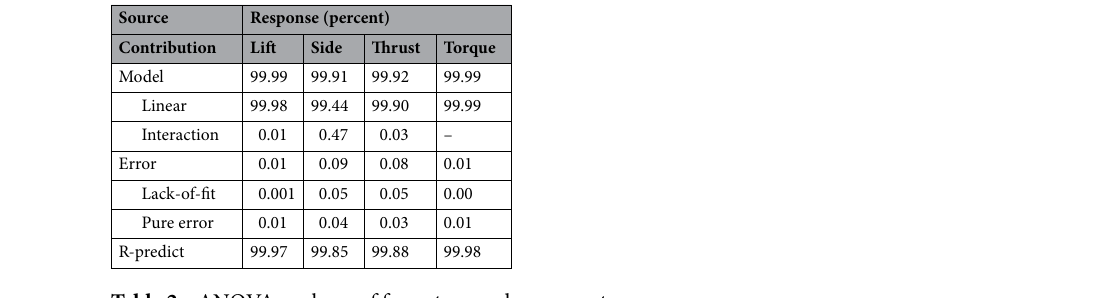
Table 2. ANOVA analyses of force-torque